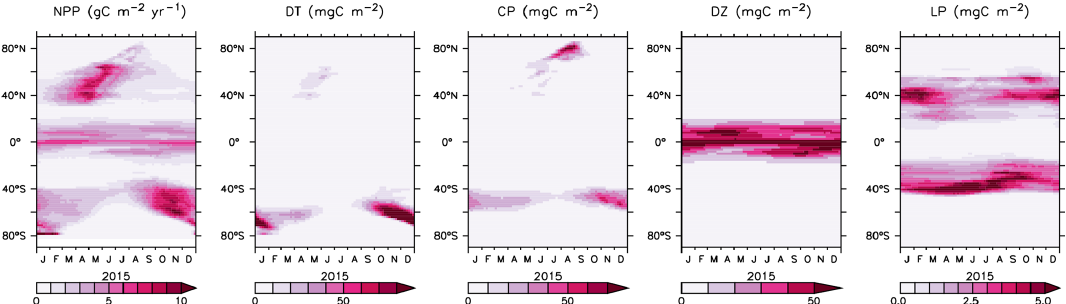
Figure 17. Model year 2015 zonally averaged surface NPP and phytoplankton biomass.